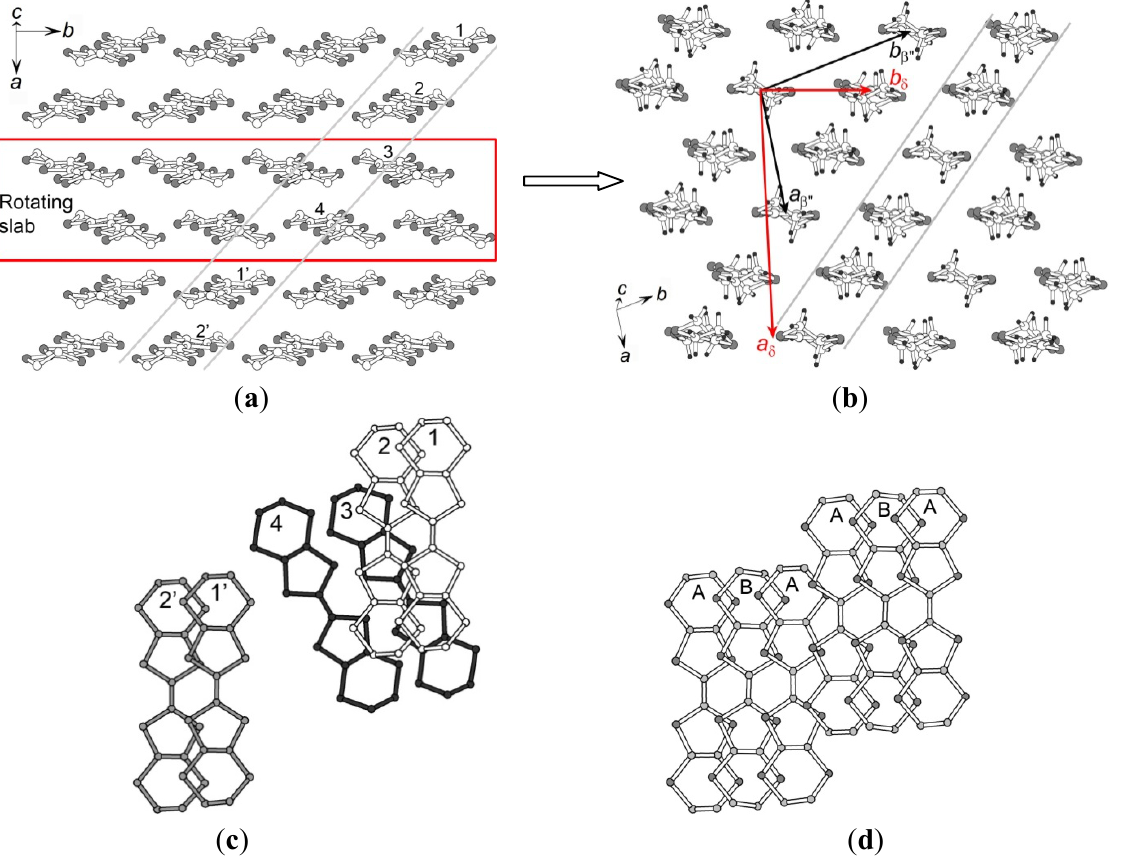
Figure 5. Scheme of the δ to β " transformation. Rotation of a double BEDT-TTF slab in the δ -layer ( a ) leads to formation of the β "-layer ( b ). Directions of the lattice axes in δ - and β "-structures are shown in ( b ) by red and black arrows, respectively. Overlaps of the molecules inside the stacks defined by grey lines in ( a ) and ( b ) are presented in ( c ) and ( d ),